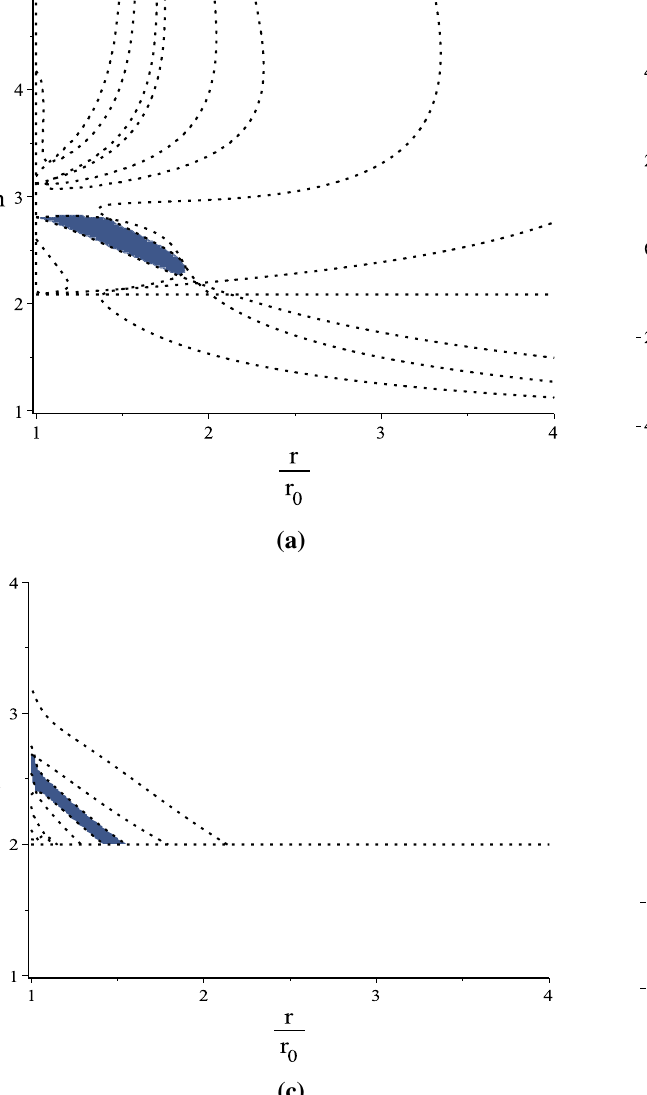
Fig. 9 Similar to the previous model, there are asymptotically spheri- cal ( a ) and hyperbolic ( c ) wormholes in Hu–Sawicki model that respect the NEC. In b we draw F and WEC2,3 for an asymptoticly spherical